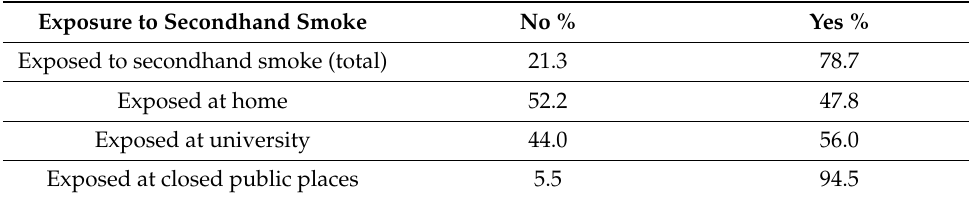
Table 3. Students’ exposure to secondhand smoke.